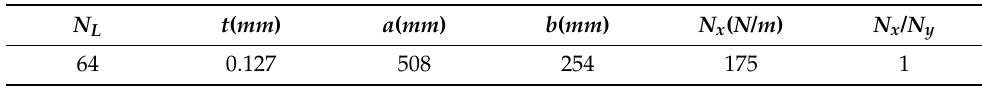
Table 2. Graphite-epoxy lamina’s geometrical and loading